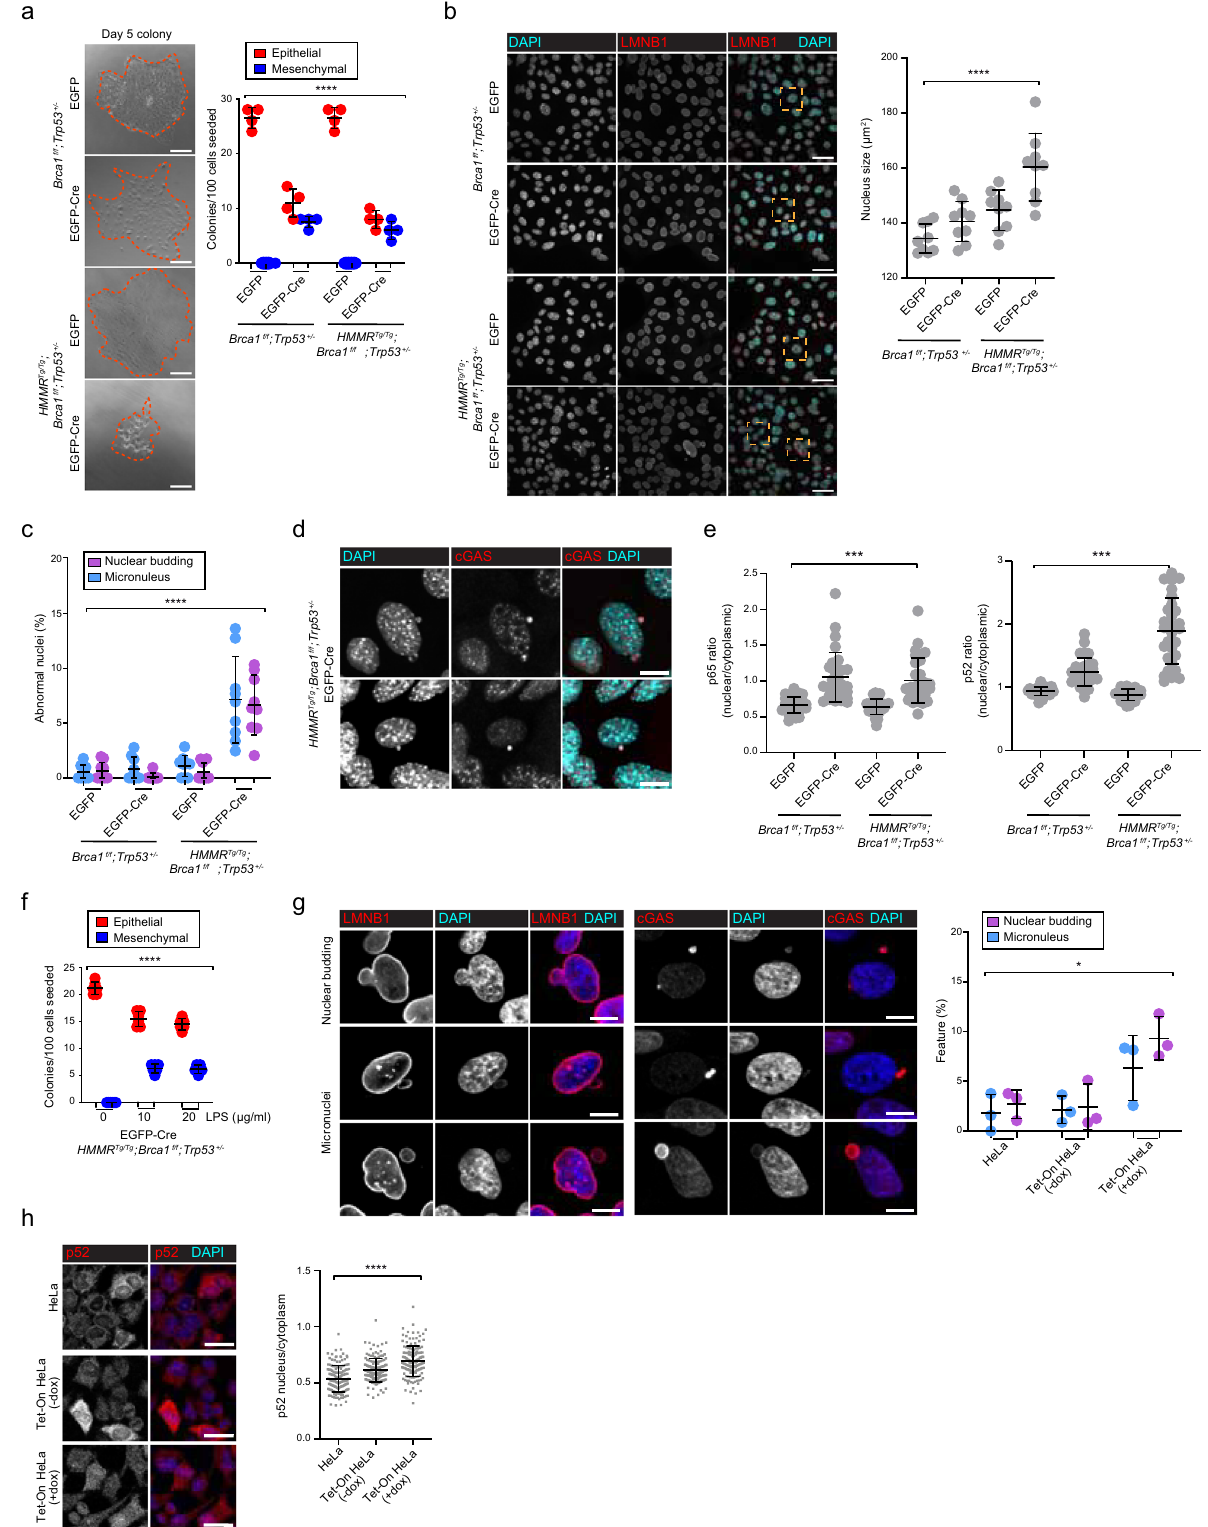
BRCA1 -associated breast cancer risk with the identi fi cation of examination of the nuclear architecture showed that colonies cGAS-stimulator of interferon genes (STING) and innate immune with HMMR overexpression also had more frequent nuclear system-related gene sets in the analysis of the GWAS results (Sup- budding and micronuclei (Fig. 4c and Supplementary Fig. 12d), plementary Data 1a). which were found to localize the cyclic GMP-AMP synthase (cGAS) Activation of cGAS-STING by genomic instability and (Fig. 4d), a cytosolic sensor of double-stranded DNA that fosters micronuclei 27 – 30 can trigger canonical and non-canonical NF- κ B in fl ammatory gene expression 27 – 30 . This signaling was also linked to NATURE COMMUNICATIONS| (2022) 13:1895